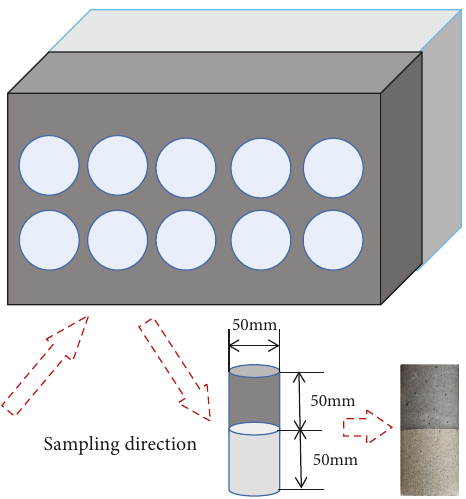
Figure 2: Sampling of layered composite